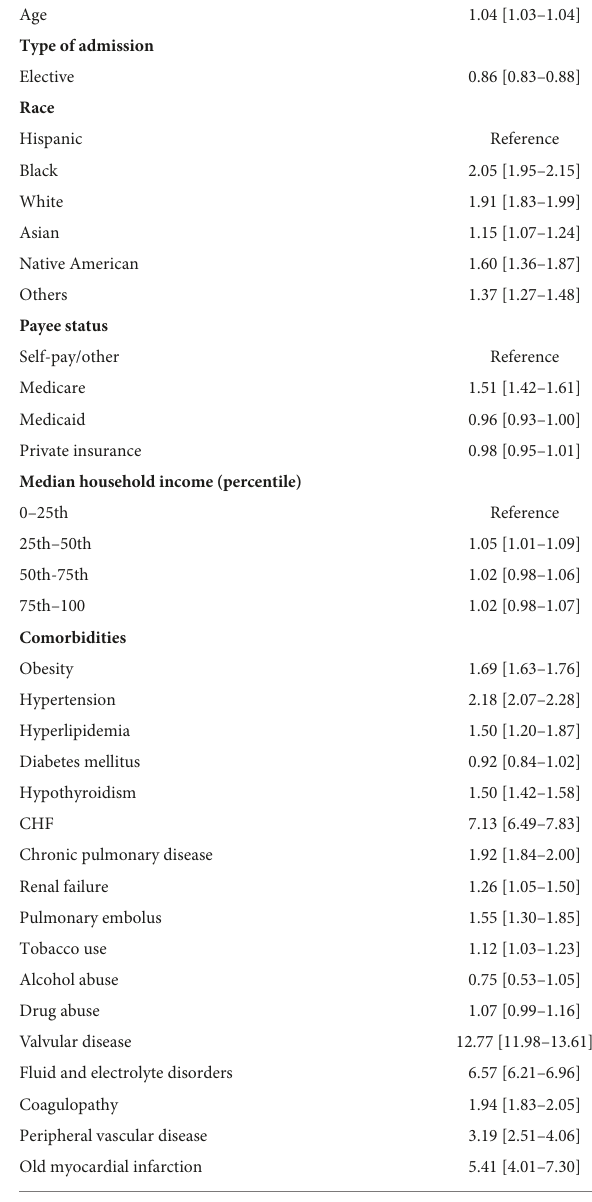
TABLE 3 Outcomes in delivery hospitalizations with and without arrhythmias. Arrhythmia ( n = 36,442)